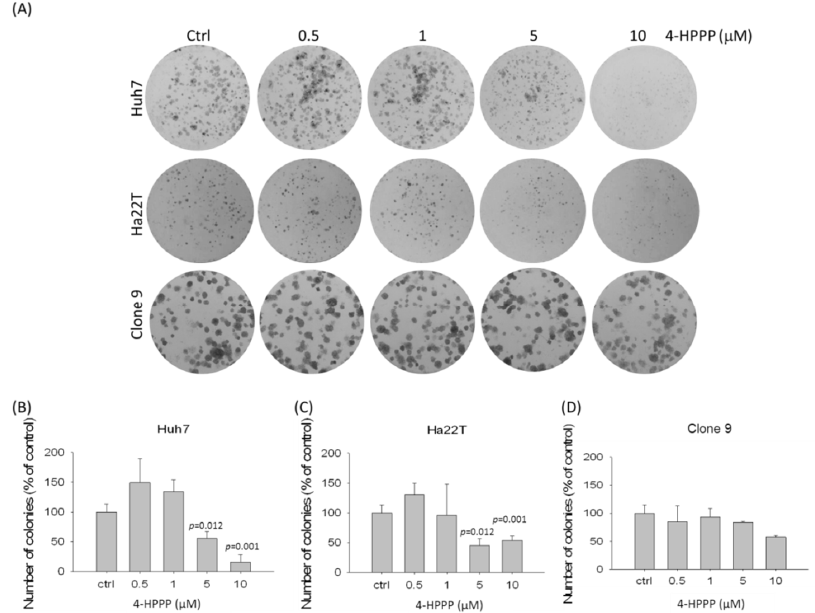
Figure 3. The inhibitory effect of 4-HPPP on the long-term proliferation of human HCC and rat hepatocyte cells. HCC cell lines Huh7 and Ha22T, and the rat hepatocyte Clone 9 were treated with indicated concentrations (from 0.5 to 10 μ M) of 4-HPPP for 7 and 10 days respectively. Afterward, cells were fixed with 4% paraformaldehyde and stained with Giemsa dye. ( A ) The representative results of colony formation of Huh7, Ha22T and Clone 9 cells following 4-HPPP treatment. ( B – D ) The quantitative analysis of ( A ). Data were statistically analyzed with the Student t-test. p value, vehicle control vs. 4-HPPP treatments. Ctrl indicates the vehicle